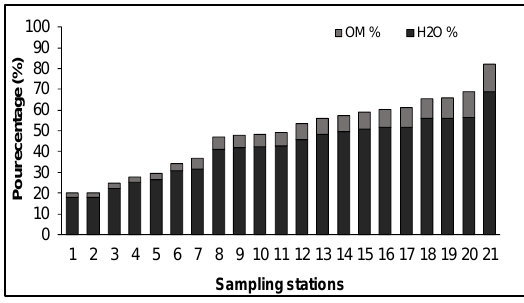
Figure 4. Water and organic matter content of sediments expressed in percentage